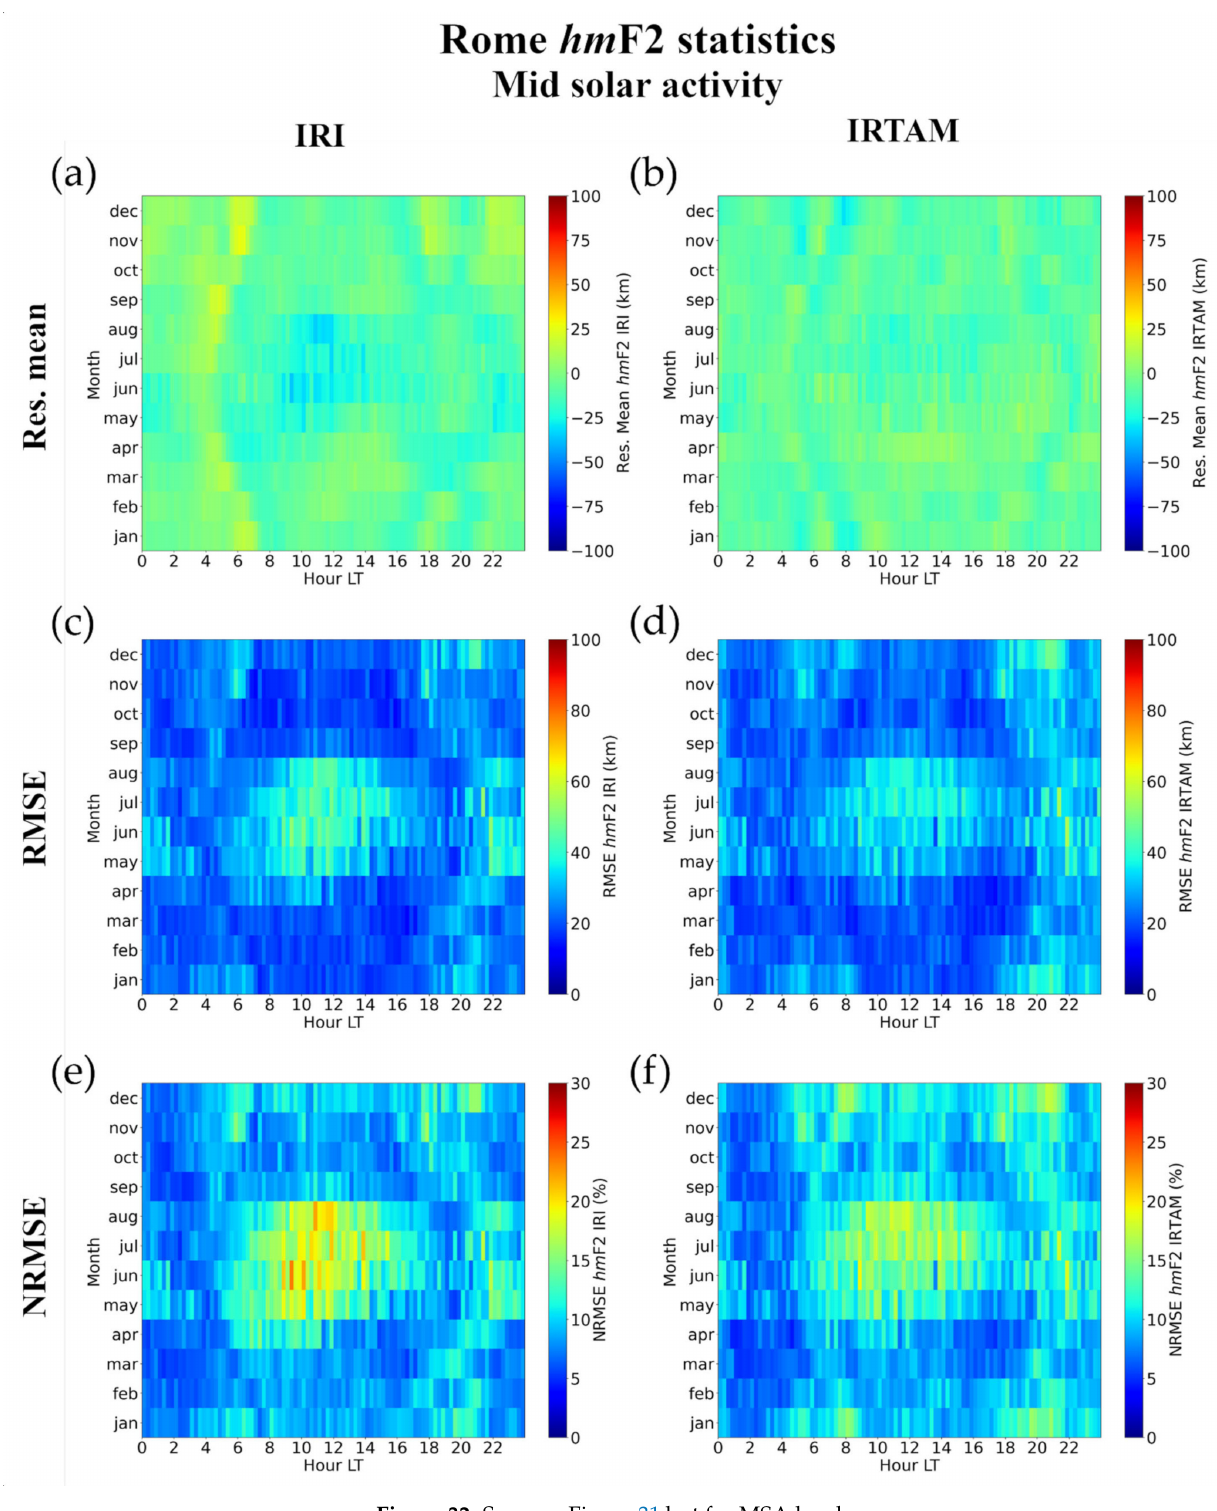
Figure 32. Same as Figure 31 but for MSA